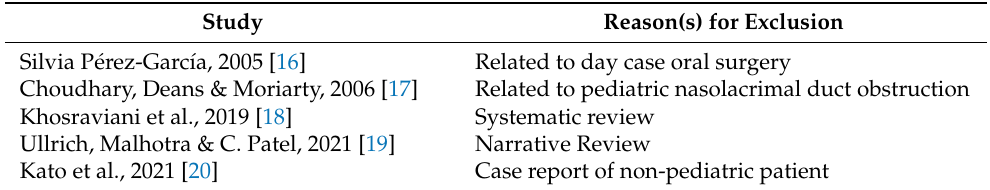
Table 1. Methodological list of studies excluded from this review and the reasons for exclusion ( n = 5). Study Reason(s) for Exclusion Silvia P é rez-Garc í a, 2005 [16] Related to day case oral surgery Choudhary, Deans & Moriarty, 2006 [17] Related to pediatric nasolacrimal duct obstruction Khosraviani et al., 2019 [18] Systematic review Kato et al., 2021